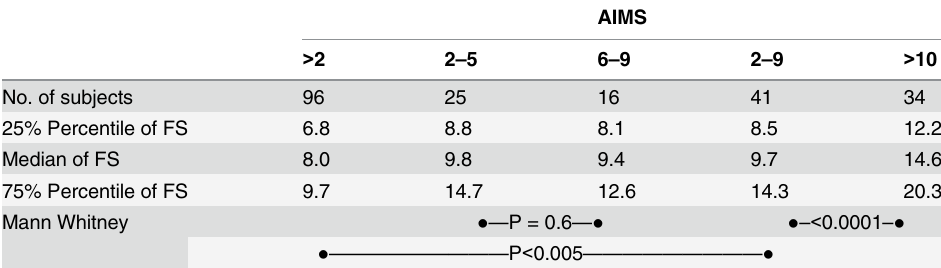
Table 2. Relationship between AIMS and Fluctuation